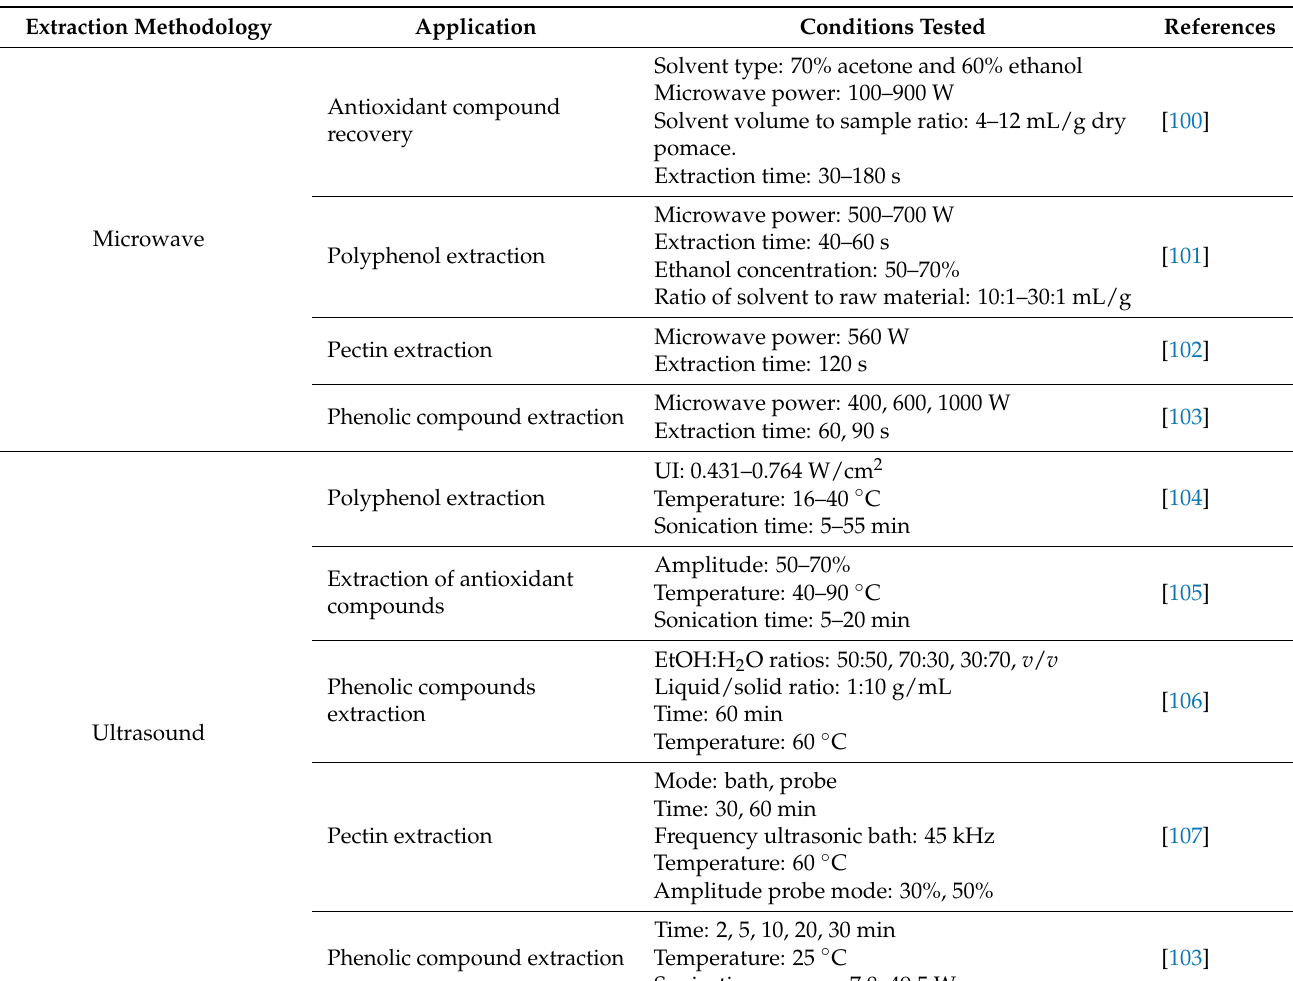
Table 3. Summary of the sustainable treatments applied to apple